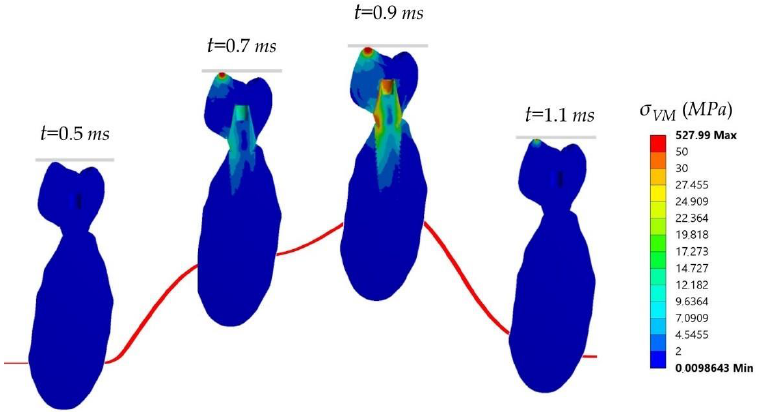
Figure 1. Distribution of Von Mises stresses (MPa) on the longitudinal section of model carbon fiber ceramic crown (FCCER) after the impact at different time steps. From left to right: 0.5 ms, 0.7 ms, 0.9 ms, and 1.1 ms. Adapted from [21].